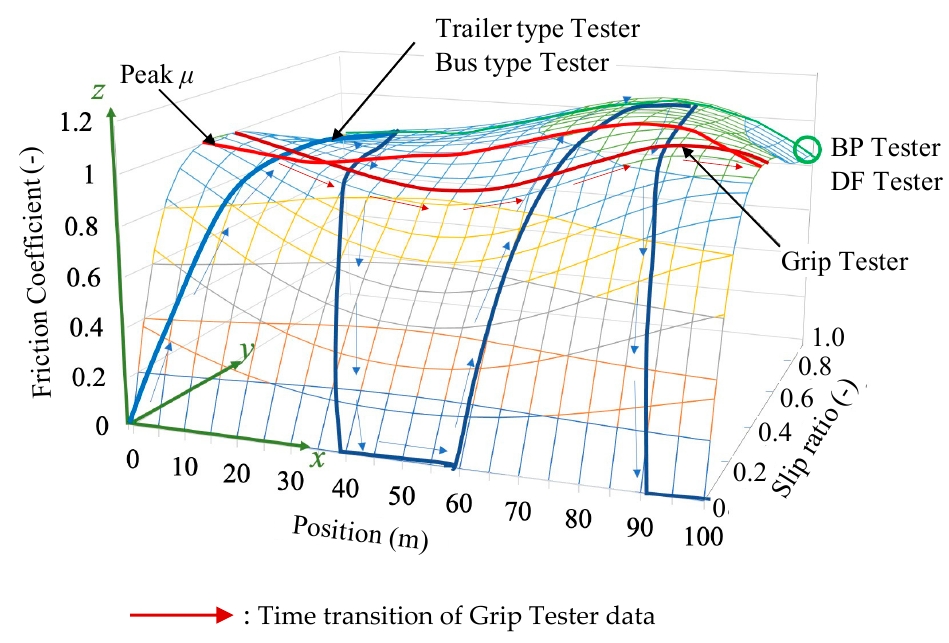
Figure 9. Image of μ - s characteristics on actual roads and of the various measurement system data [4].